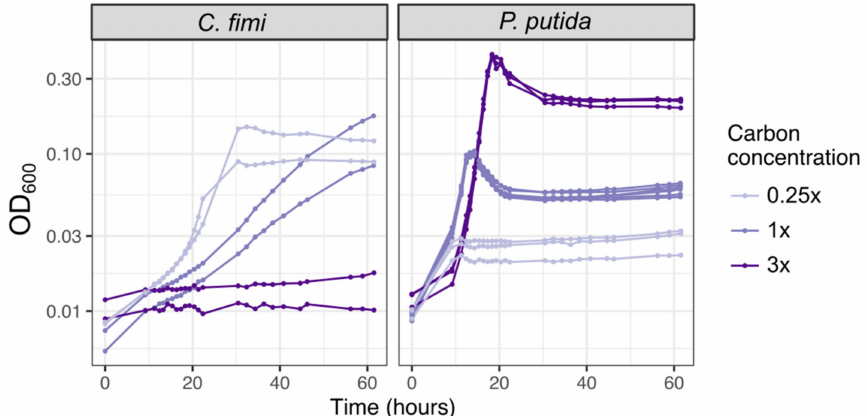
Figure 6. Higher carbon concentrations in model lignocellulose medium result in slower growth and higher final yield; C. fimi is more strongly inhibited than P. putida . Each species was grown in pure culture in Model Lignocellulose medium (Table 1) with either 1 × carbon (4 mM cellobiose, 5 mM xylose, 4 mM vanillic acid), or 0.25 times or 3 times those